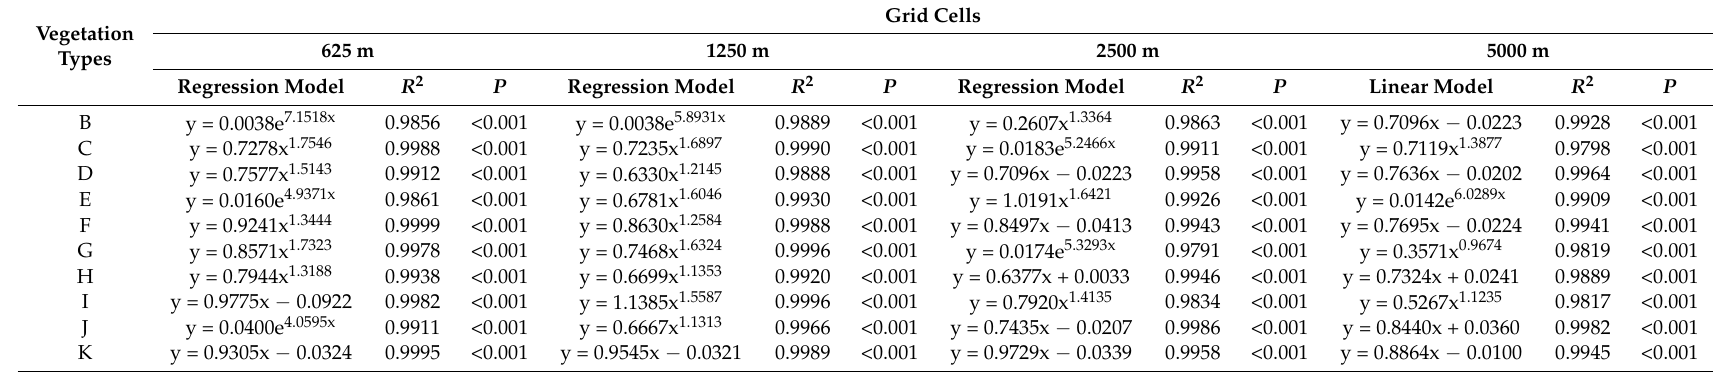
Table 5. The regression models between the Moran’s I of ten vegetation types and those of all the destructed vegetation across the lag distance of 625 m, 1250 m, 2500 m, and 5000 m comparatively at four corresponding aggregation levels. The vegetation type abbreviations are defined in Table 4. Vegetation